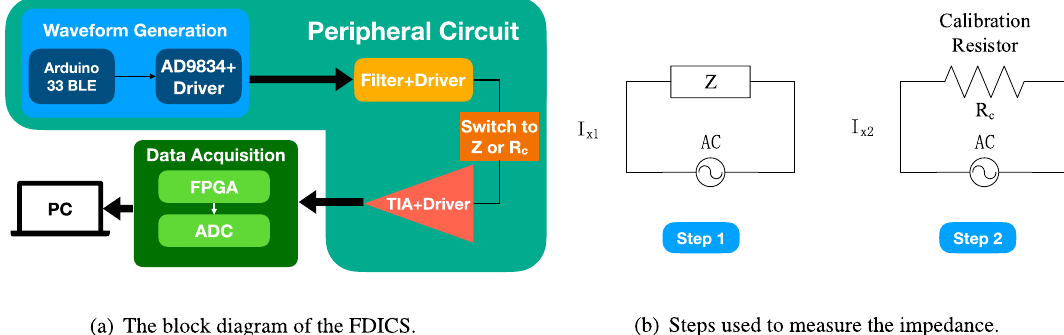
Figure 2. The block diagram of the proposed FDICS and the steps to measuring the